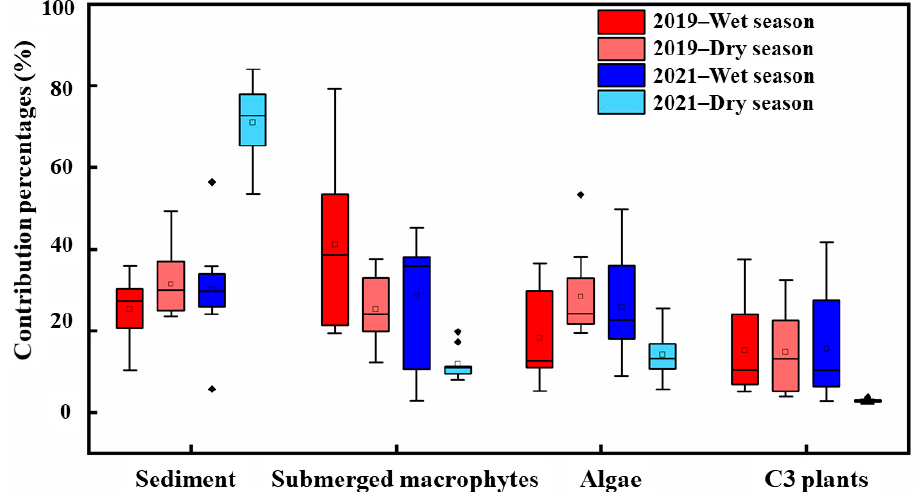
Figure 8. Relative contribution percentages of sediment, submerged macrophytes, algae, and C3 plants to POM in water of Caohai Lake. Red, light red, blue, and light blue represent the 2019 − wet season, 2019 − dry season, 2021 − wet season, and 2021 − dry season, respectively.